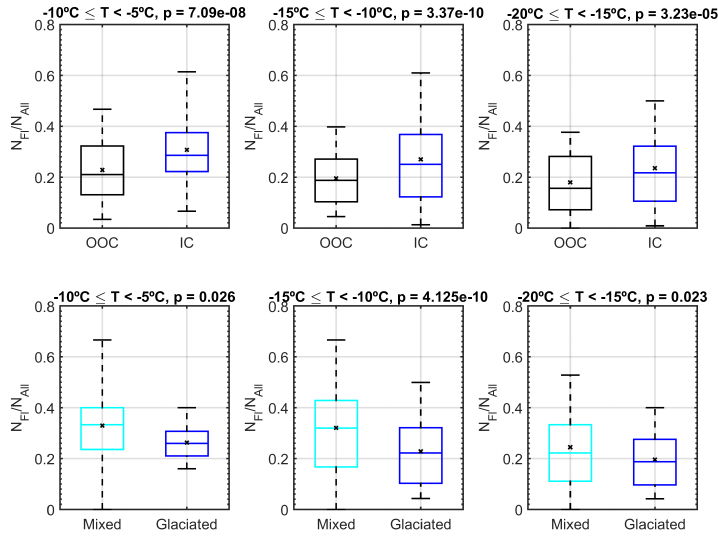
Figure 7. Top panels: influence of cloud on fluorescent fraction for the studied temperature regimes. Bottom panels: influence of cloud type on fluorescent fraction for the studied temperature regimes. Box and whiskers denote 5th, 25th, 50th, 75th, and 95th percentiles; x marker denotes mean. ANOVA one-way p values indicated at top of each